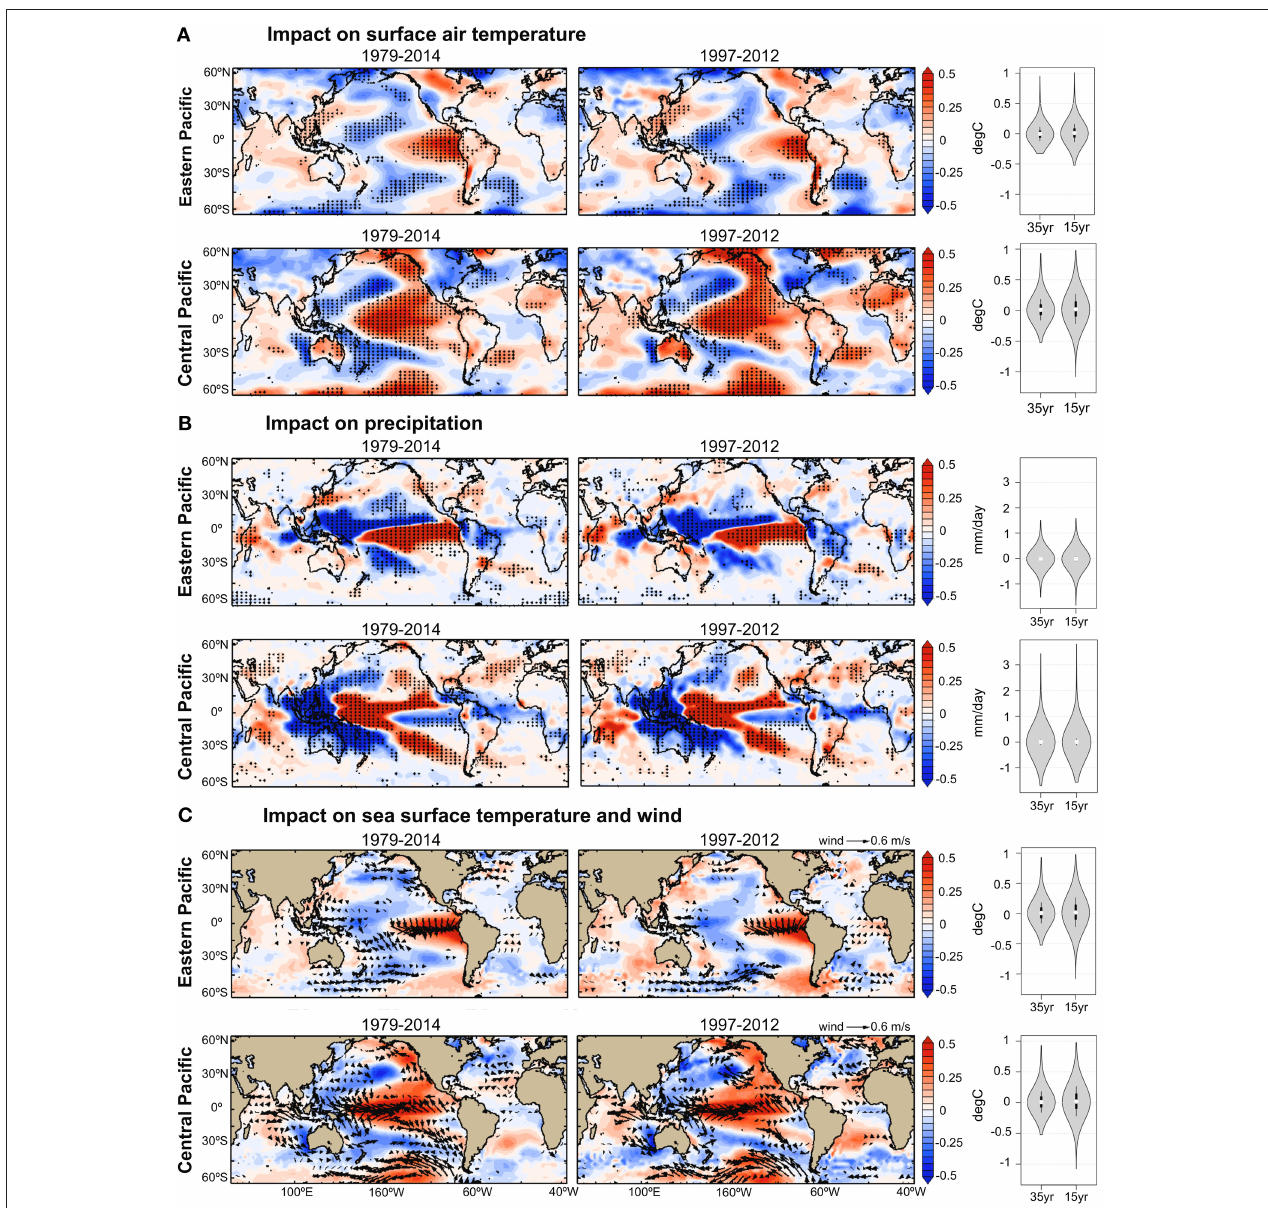
FIGURE 4 | Observed impacts of Eastern and Central Pacific El Niño on physical variables during the periods 1979–2014 and 1997–2012. Annual mean anomalies are regressed onto the annual mean EP and CP El Niño indices. Increase and decrease are indicated by positive (red) and negative (blue) anomalies respectively. In all panels, stippling indicates where the regression coefficients are significant at the 90% confidence level over the entire 35-year period (1979–2014; left panels) and 15-year period (1997–2012; central panels). The statistical significance of these regression coefficients was estimated according to Student t -test and considering the autocorrelation of the time-series. The probability density distributions of the regression coefficients are shown in gray shading for the 35 and 15-year periods (right panels). The white dot indicates the position of the median, and the upper and lower ends of the black rectangle indicate the upper and lower quartiles respectively. Surface air temperature and precipitation datasets are from NCEP/NCAR reanalysis, and sea surface temperature and wind datasets are from ECMWF reanalysis (see Table 1 ). The impact values are estimated based on EP and CP indices equal to